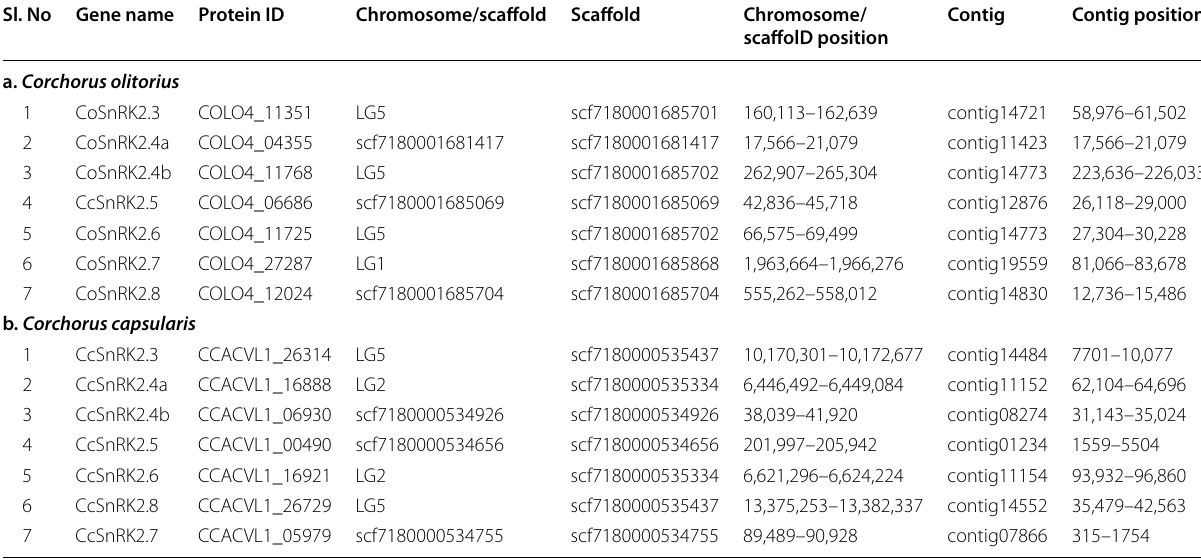
Table 1 Chromosomal locations of validated CoSnRK2 and CcSnRK2 genes Sl. No Gene name Protein